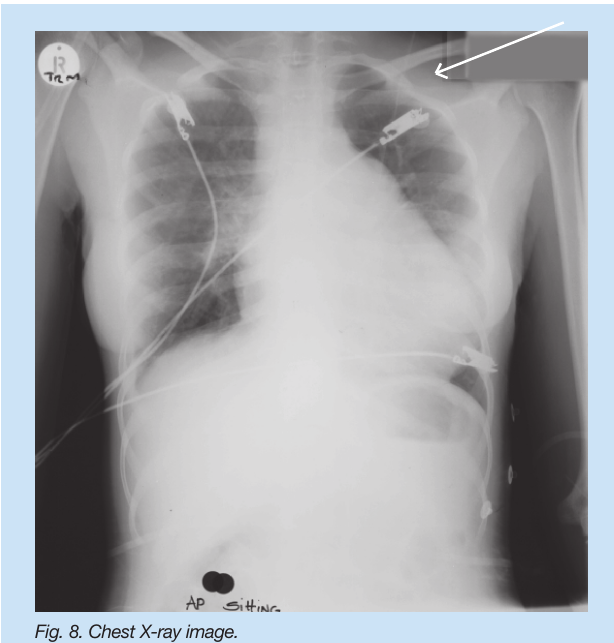
Fig. 8. Chest X-ray